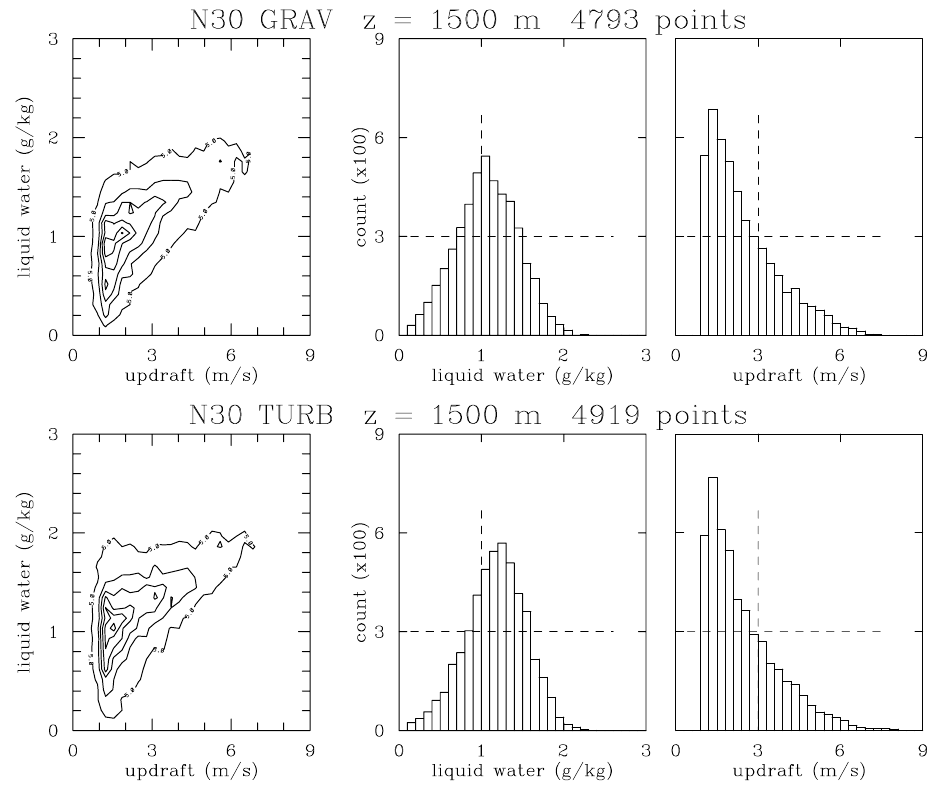
Figure 5. Left two panels: joint histograms of the updraft velocity and liquid water mixing ratio for cloud updrafts ( q c > 0 . 1gkg − 1 and w > 1ms − 1 ) at height of 1500m. Right four panels: marginal histograms for the liquid water and updraft velocity obtained from joint histograms. Histograms are generated applying 30 bins for the liquid water and updraft velocity with the bin width of 0.1gkg − 1 and 0.3ms − 1 . N30 GRAV and TURB simulations. Dashed lines in marginal histograms highlight the